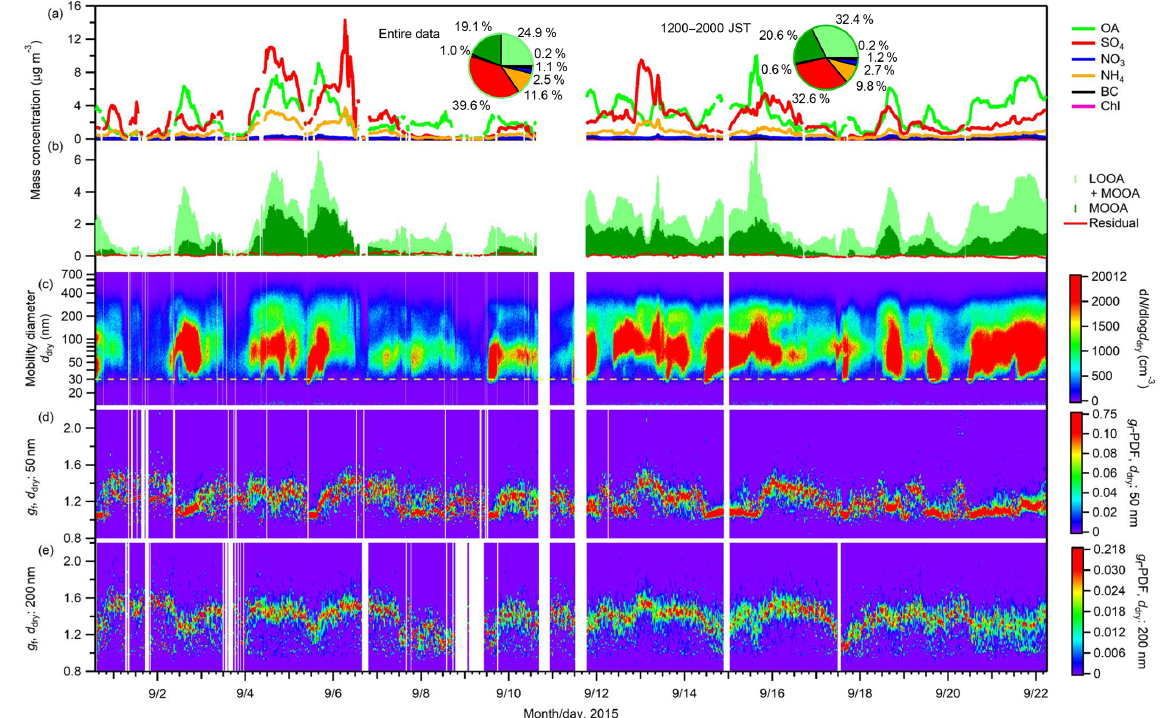
Figure 1. Time series of (a) sub-micrometer mass concentrations of non-refractory aerosol chemical components (OA, SO 4 , NO 3 , NH 4 , and Chl) from the AMS measurement and BC from the PSAP measurement; (b) mass concentrations of LOOA and MOOA, and the residuals from the PMF analysis; (c) aerosol number–size distributions; and g f -PDF of aerosol particles with d dry of (d) 50 and (e) 200nm. The two pie charts in panel (a) present the mass fractions of chemical components for the entire study period and for the afternoon hours (12:00– 20:00JST) during the study period. The dashed line in panel (c) represents a diameter of